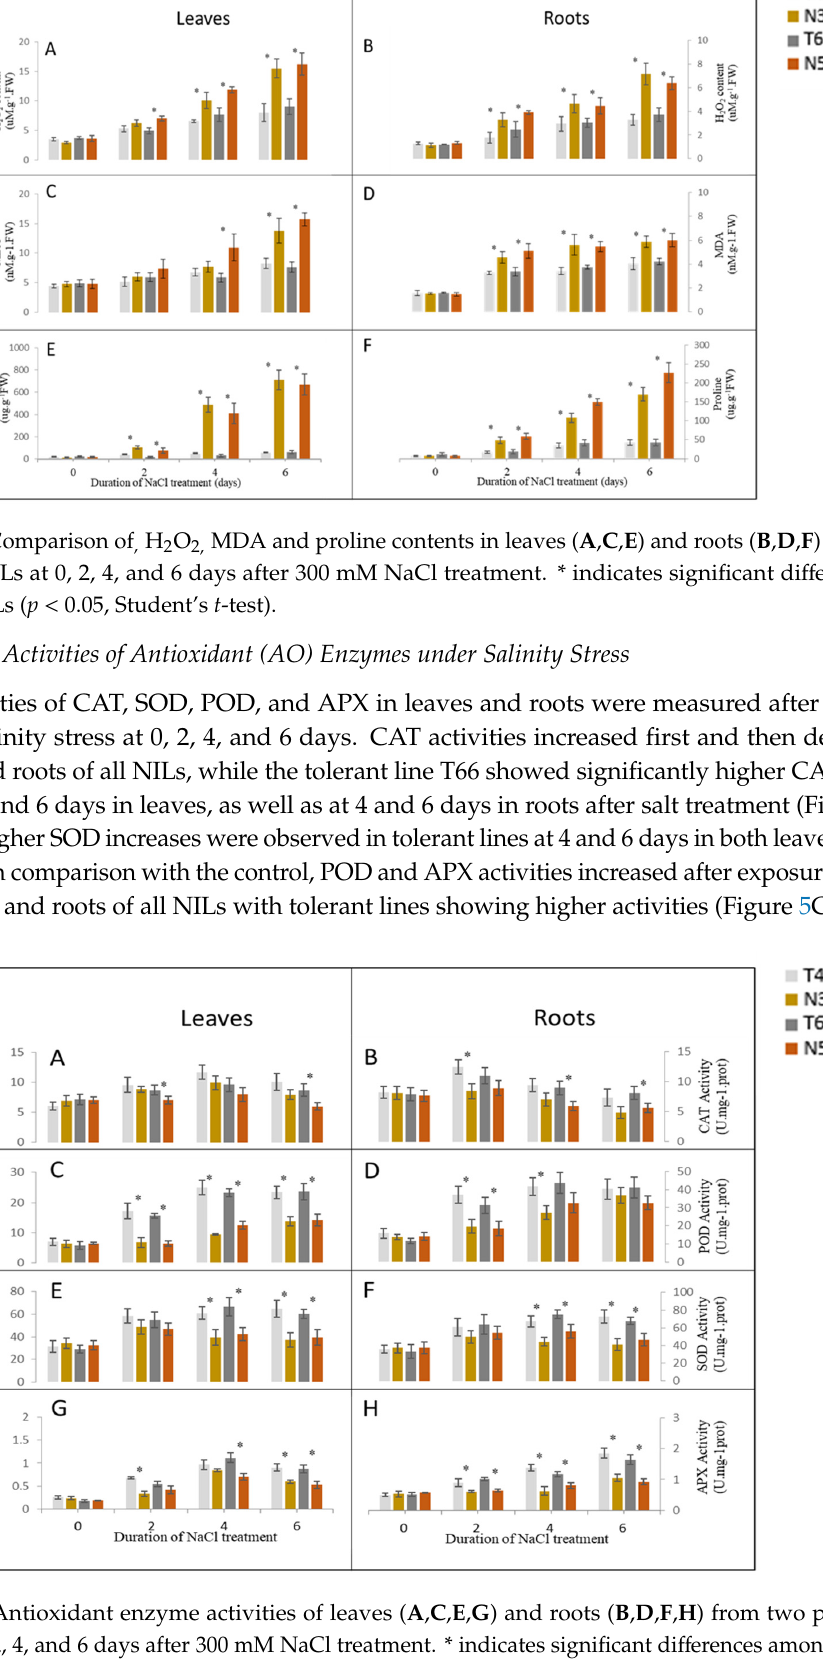
Figure 5. Antioxidant enzyme activities of leaves ( A , C , E , G ) and roots ( B , D , F , H ) from two pairs of NILs at 0, 2, 4, and 6 days after 300 mM NaCl treatment. * indicates significant differences among NILs ( p < 0.05, Student’s t ‐ test).